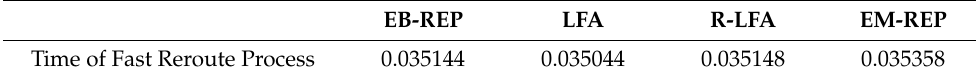
Table 14. Comparison of FRR